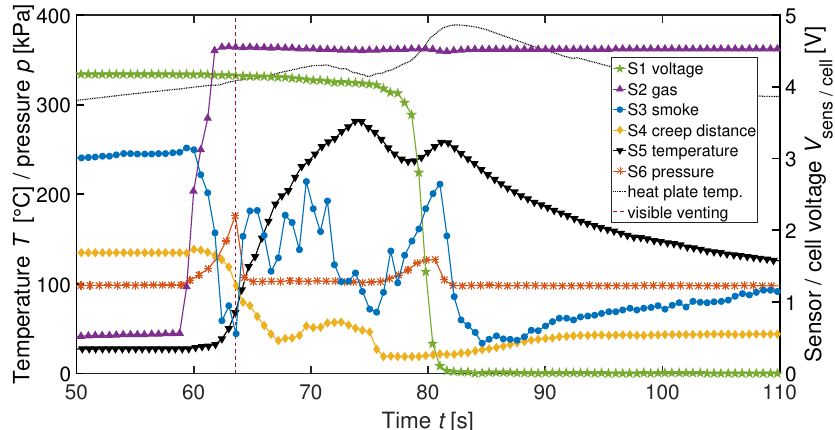
Figure 2. Readings of the sensors in test V1. The dashed line labeled with “visible venting” indicates the time when a venting was visible outside of the battery housing. All sensors detect the thermal runaway effects of the cell within a time window of about t detecWin ≈ 20s.